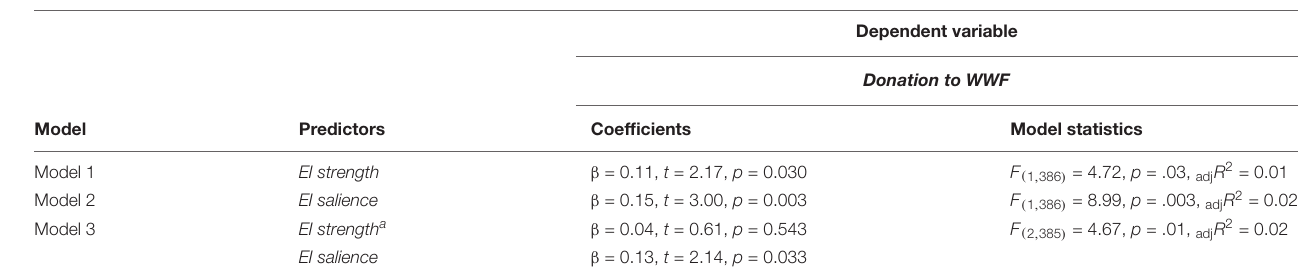
TABLE 4 | Linear regression models (Study